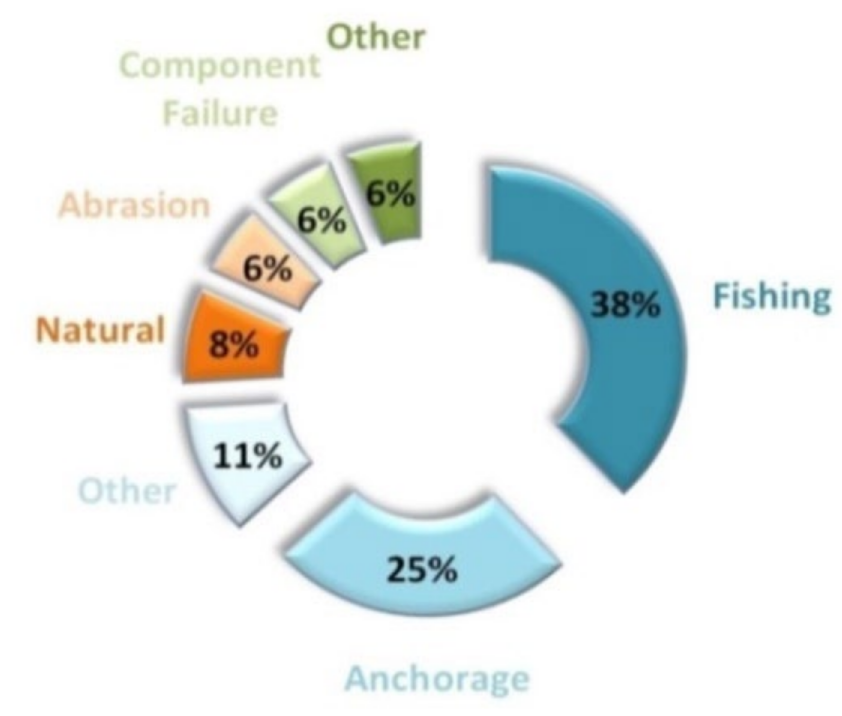
Figure 35. Dangers of submarine cable systems (in